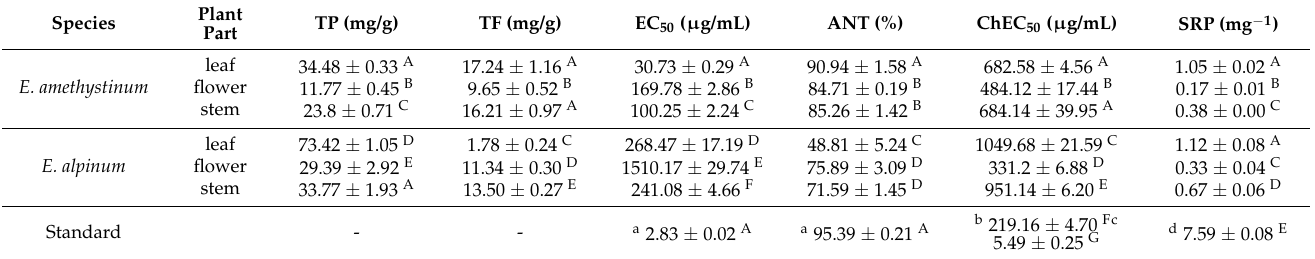
50 ) and slope of trendline in a reducing power assay (SRP)